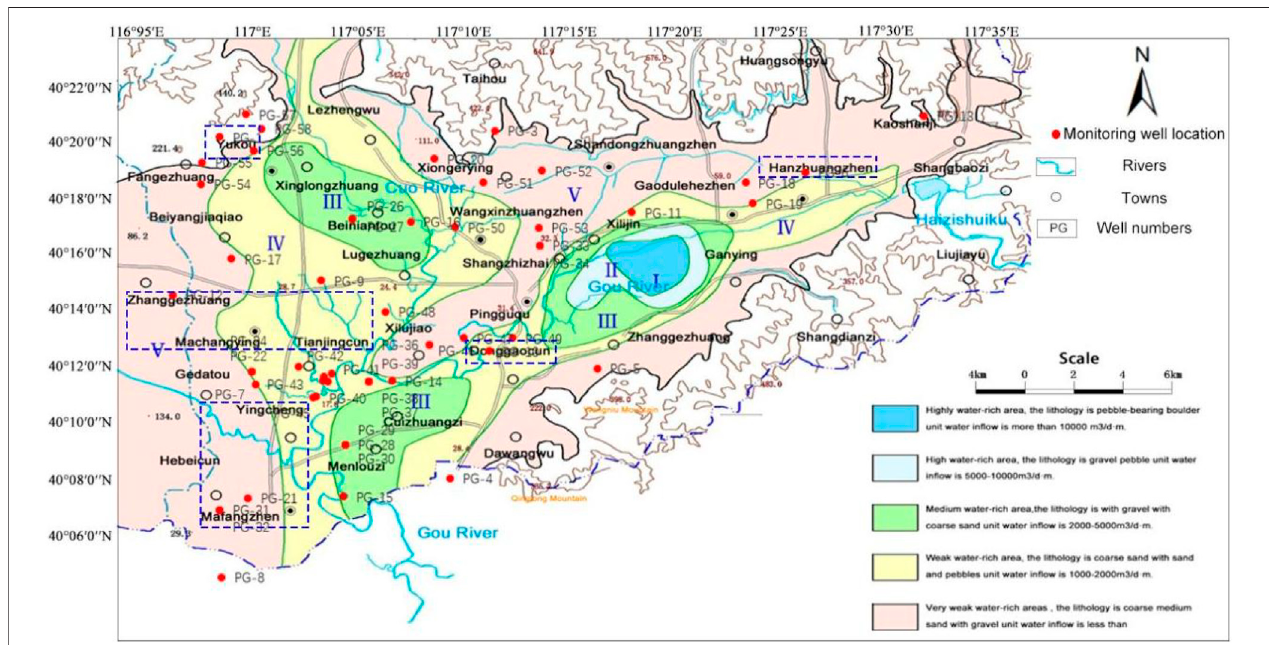
FIGURE 1 | Hydrogeologcial setting of the Pinggu Basin and location of the monitoring